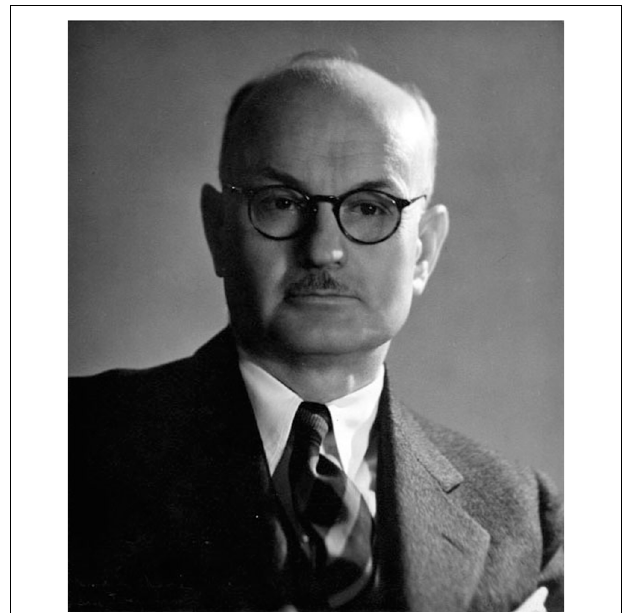
FIGURE 1 | Edward Chace Tolman